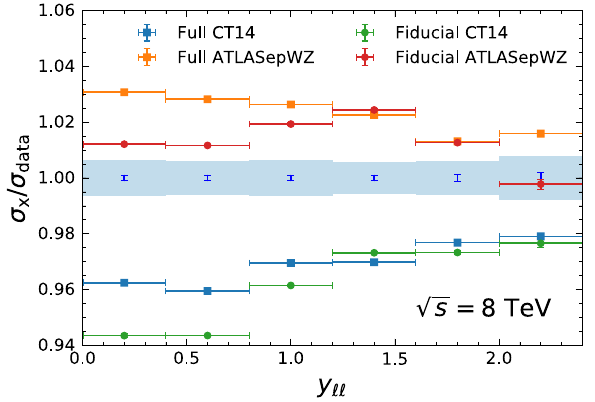
Fig. 9 Ratio of the predicted to the measured d σ/ d y (cid:4)(cid:4) cross section. The ratios are calculated in the full or fiducial phase space using the CT14NNLO and ATLAS-epWZ PDF sets, as indicated in the legend. The error band (bars) centered at one shows the data total experimen- tal (statistical) uncertainty. The error bars for the ratios of the data to predicted cross sections show estimated statistical uncertainties of the predictions. Global normalization uncertainty of 1 . 9% is not shown The comparison between the full phase space